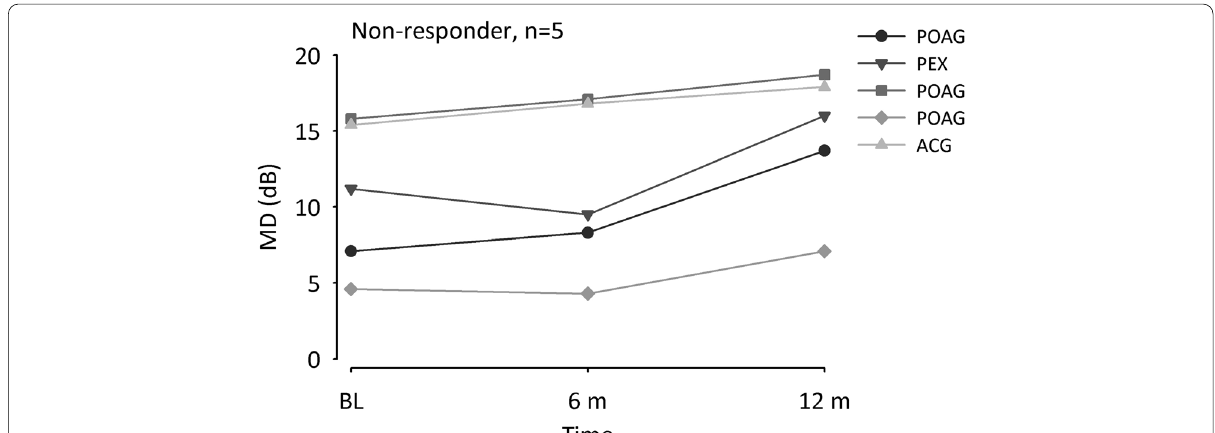
Fig. 4 Line graphs of mean defect (MD) in five non-responders before optic nerve stimulation (PRE), and 6 and 12 months after treatment. Patients suffered from primary open-angle glaucoma (POAG), angle-closure glaucoma (ACG), or pseudoexfoliative glaucoma